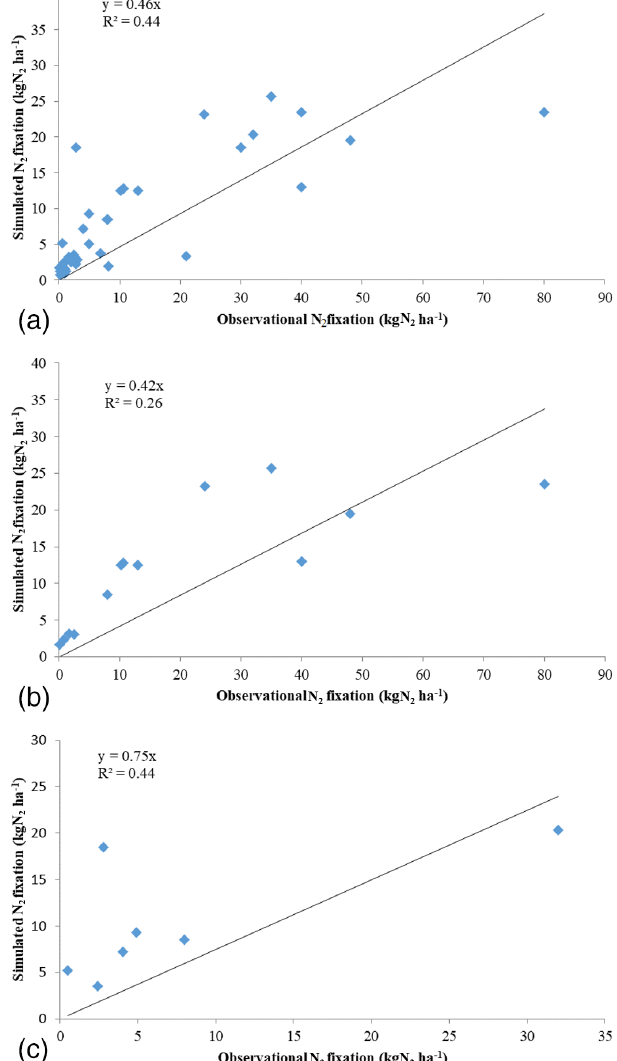
Figure 2. Comparison between modeled and observed nitrogen fix- ation rate at site level: (a) all sites, (b) temperate forest, (c) tropical forest (data listed in Table 2). The y axis is simulated N 2 fixation, while x represents the observational N 2